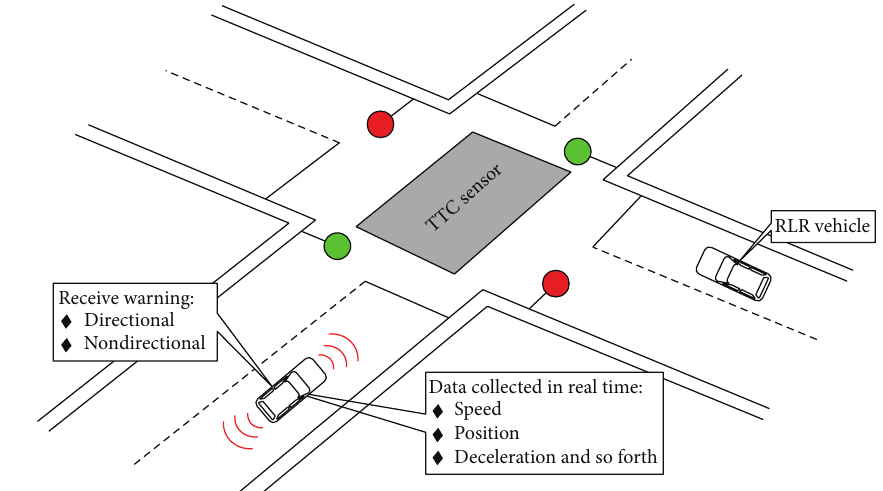
Figure 2: Design of experimental scenario.